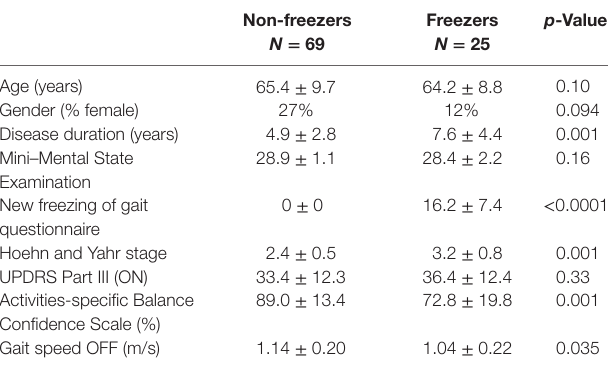
TaBle 1 | Subjects characteristics in Parkinson’s disease (PD) freezers and PD non-freezers.